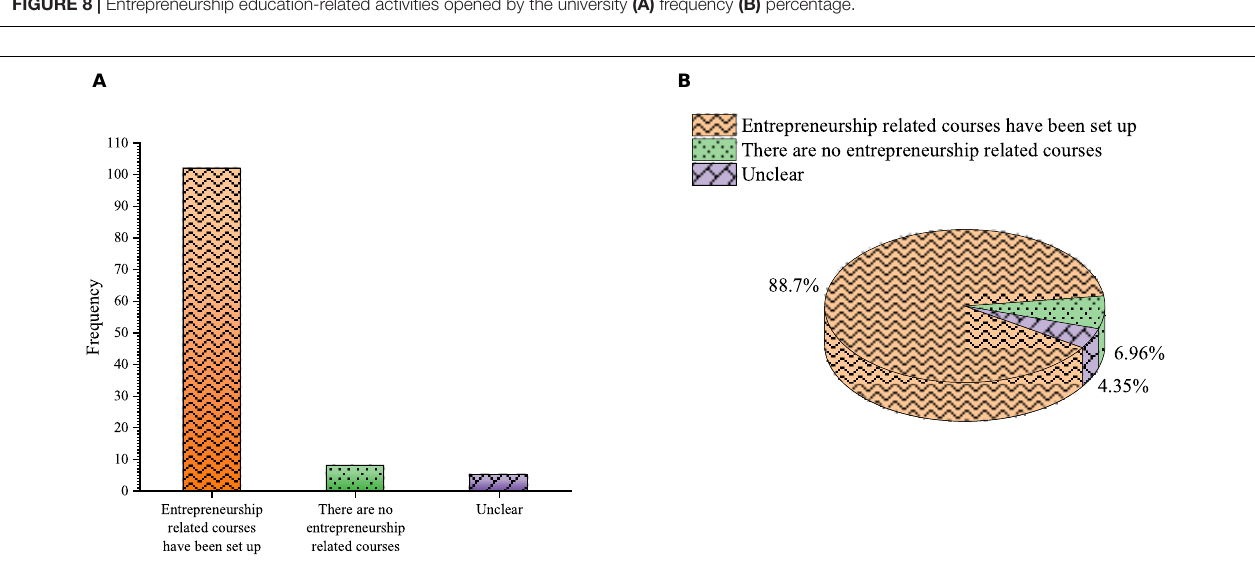
FIGURE 9 | Whether the university opens entrepreneurship curriculum (A) frequency (B) percentage.